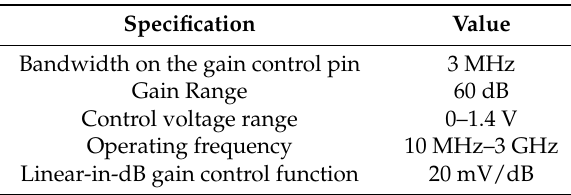
Table 4. Specification of the VGA (ADL5330).